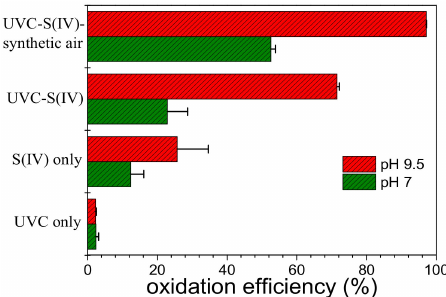
Figure 1. As(III) oxidation e ffi ciency by the UVC-S(IV)-O 2 system and related control systems after a reaction time of 10 min. Initial conditions: [S(IV)] 0 = 2 mM, [As(III)] 0 = 5 µ M. For most experiments, reaction solutions were stirred and exposed to the air, except in experiments with bubbling of synthetic air at a flow rate of about 500 mL min − 1